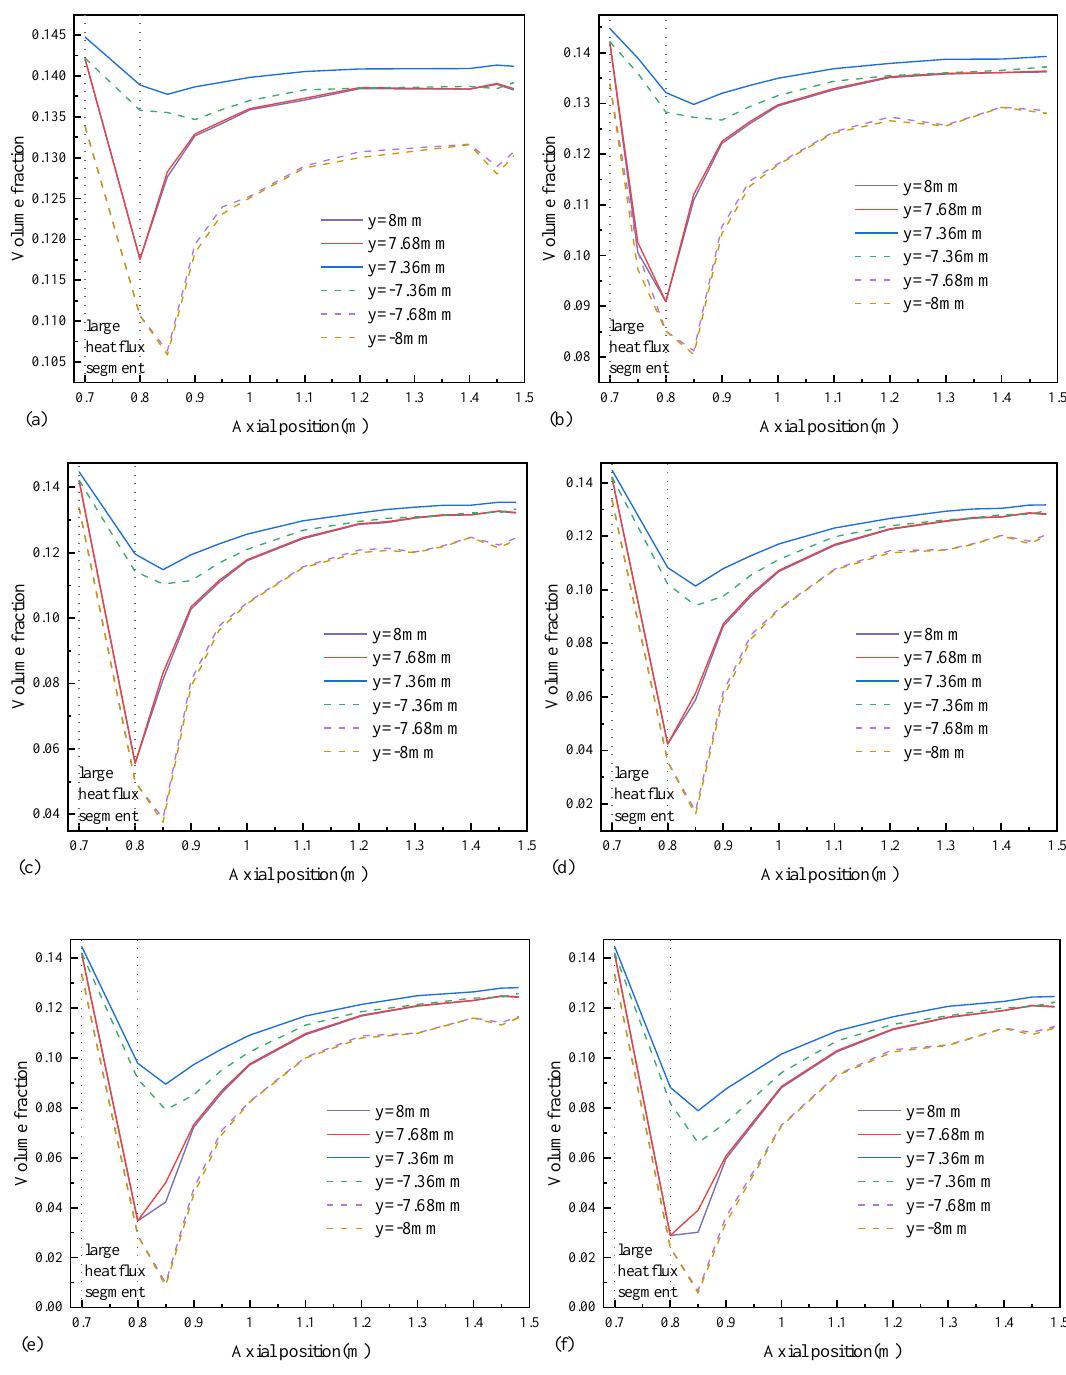
Figure 13. Axial variation of IVF at six monitoring points on the same vertical line for six large heat flux multiples ( a ) 5, ( b ) 10, ( c ) 20, ( d ) 30, ( e ) 40, ( f ) 50 times. Figure 14 indicates the average heat transfer coefficient for each section at different multiples of local large heat flux. It can be noticed that in Section II, the average heat trans- fer coefficient increases with the increasing multiples of heat flux due to the near-wall melting. This is because the boundary is severely damaged, which strengthens the heat and mass transfer between the mainstream region and the near-wall region. The average heat transfer coefficient of Section III changes slightly for 5 – 20 multiples while decrease with the increase of heat flux for multiples bigger than 20. This is presumed to be caused by the thermophysical properties of the ice slurry as well as changes in the distribution of ice particles [32]. The viscosity as well as the effective thermal conductivity of the ice slurry increases with increasing ice concentration. In Section III, the temperature of the ice slurry increases, the IVF decreases, and the viscosity decreases, leading to a corresponding in- crease in the heat transfer coefficient. However, the effective thermal conductivity de- creases with decreasing ice content, and the heat transfer coefficient should decrease ac- cordingly. From Figure 14, it can be seen that when the heat flux is greater than 20 times, the heat transfer coefficient decreases. From this, it can be inferred that the effective ther- mal conductivity may bring more influence than the viscosity on average heat transfer coefficient.